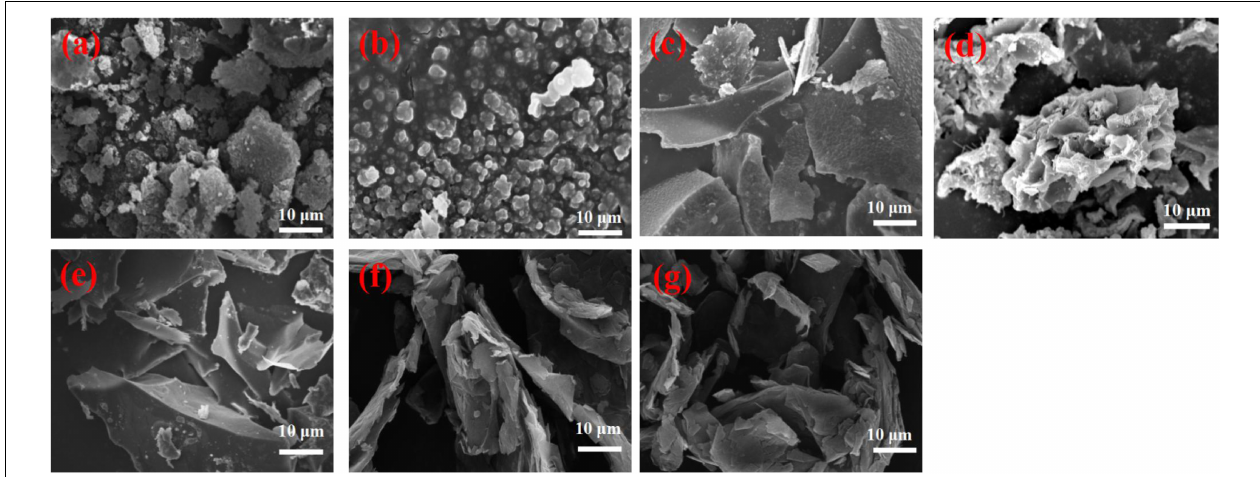
FIGURE 1 | SEM images of kraft lignin (a) , LNP (b) , and prepared carbons GN-1-LIN (c) , GN-2-LIN (d) , GN-1-LNP (e) , GN-2-LNP (f) , and commercial graphene (g) .